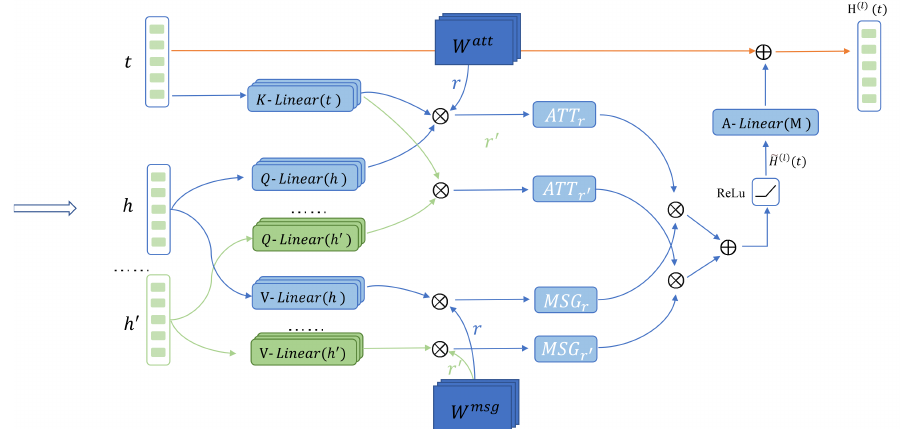
Figure 5. Event characterization